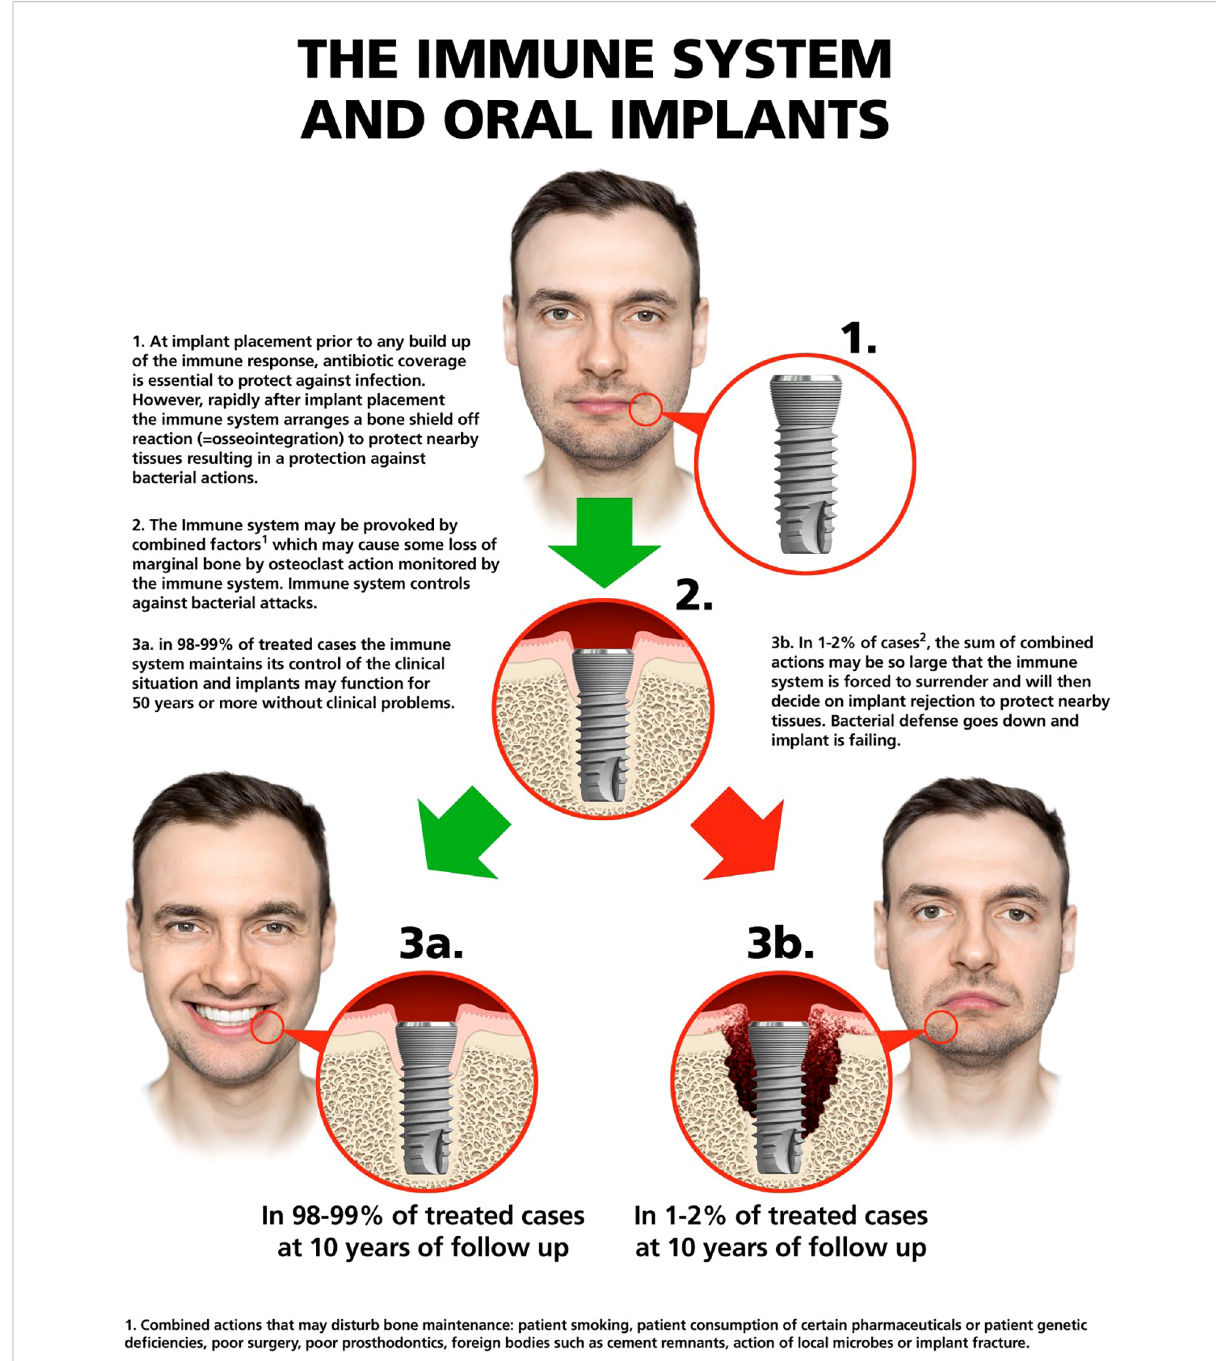
FIGURE 1 A general overview of immune system actions in relation to oral implants. Computerized image of human